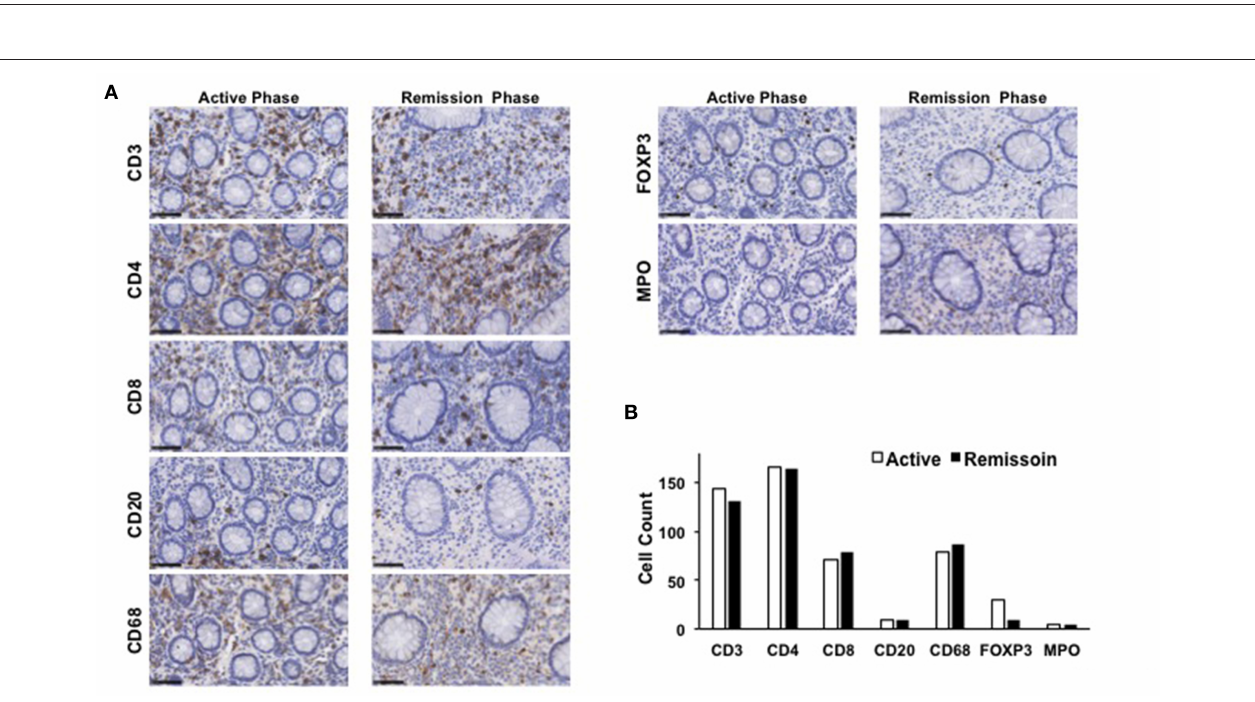
FIGURE 4 | Immunohistochemical analyses of the ascending colon biopsy samples obtained from a patient with collagenous colitis during the active and remission phases. (A) Colonic biopsy specimens were subjected to immunohistochemical analyses to visualize CD3 + T cells, CD4 + T cells, CD8 + T cells, CD20 + B cells, forkhead box P3 (FOXP3) + regulatory T cells (Tregs), CD68 + macrophages, and myeloperoxidase (MPO) + granulocytes. Scale bar, 50 µ m. (B) Cells positive for each marker was counted. Results are expressed as means.